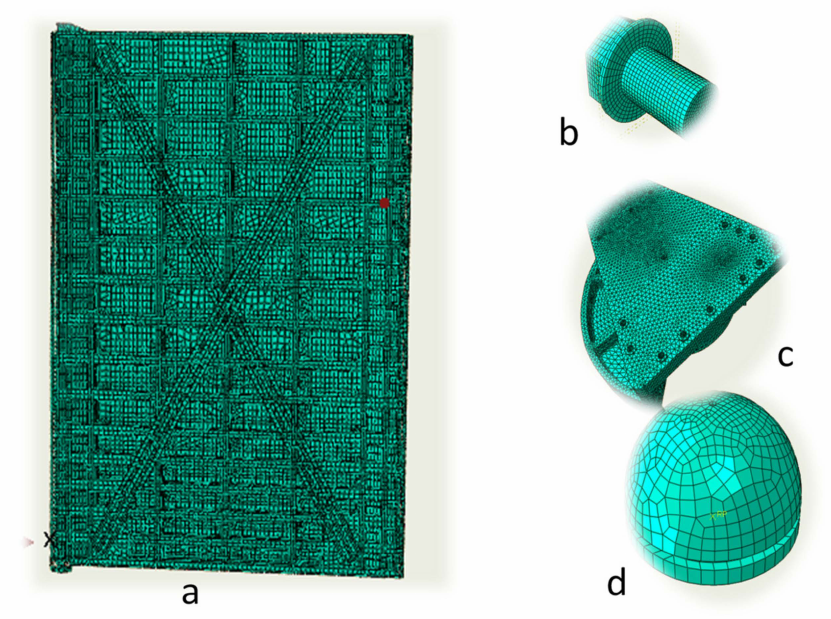
Figure 8. Main structural elements of the lower gate, Holt Lock. ( a ) miter gate leaf with 16 girders,